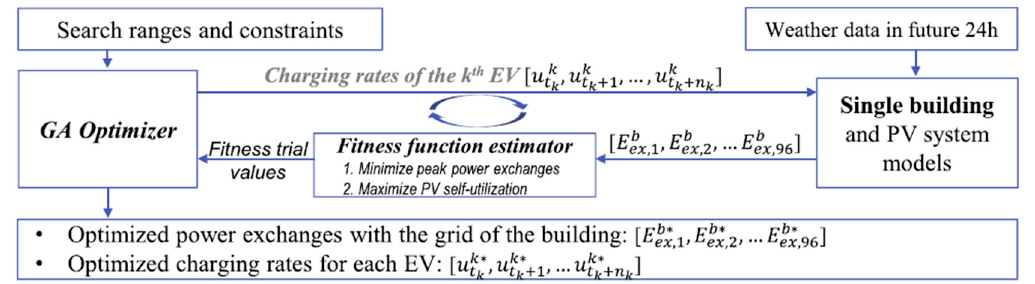
Figure 15. Optimization based algorithm for non-coordinated control.